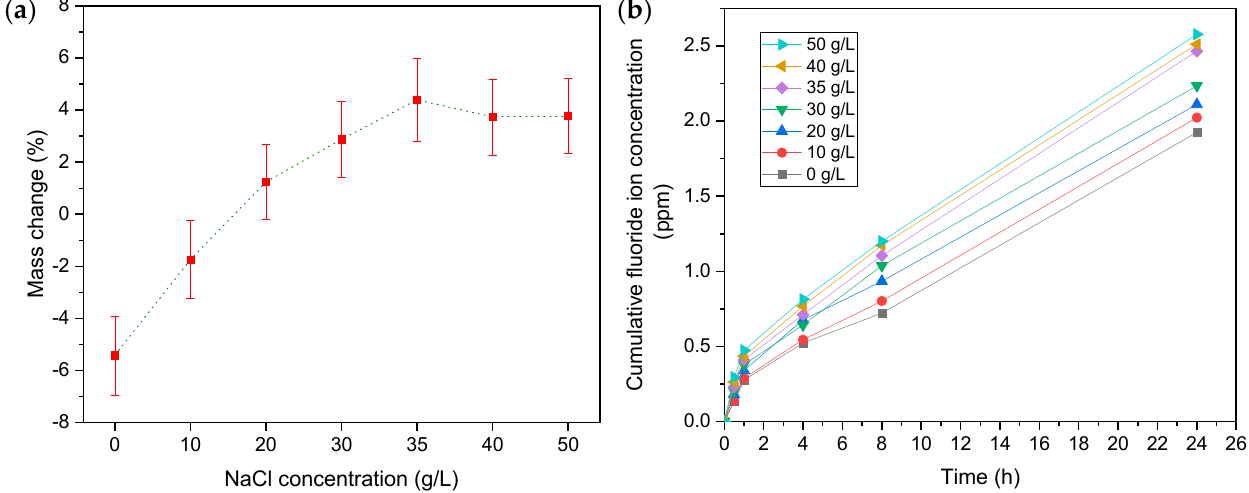
Figure 1. The e ff ects of NaCl concentrations on the degradation behavior of Na fi on: ( a ) mass change Figure 1. The effects of NaCl concentrations on the degradation behavior of Nafion: ( a ) mass change (%) with respect to the initial mass of the Na fi on membrane after 24 h ex situ Fenton’s test with (%) with respect to the initial mass of the Nafion membrane after 24 h ex situ Fenton’s test with di ff erent NaCl concentrations; ( b ) cumulative fl uoride concentration (ppm) in the Fenton’s test so- different NaCl concentrations; ( b ) cumulative fluoride concentration (ppm) in the Fenton’s test lution with time. solution with